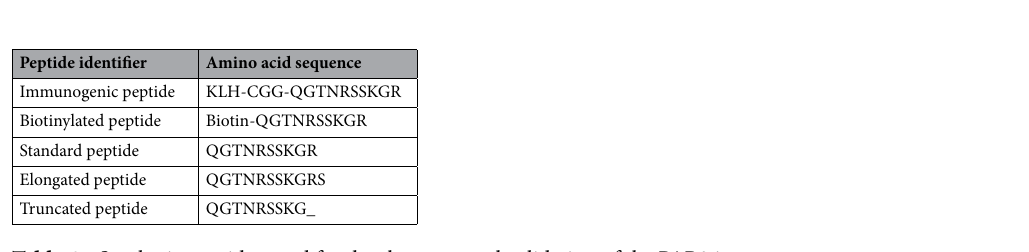
Table 4. Synthetic peptides used for development and validation of the PAR2